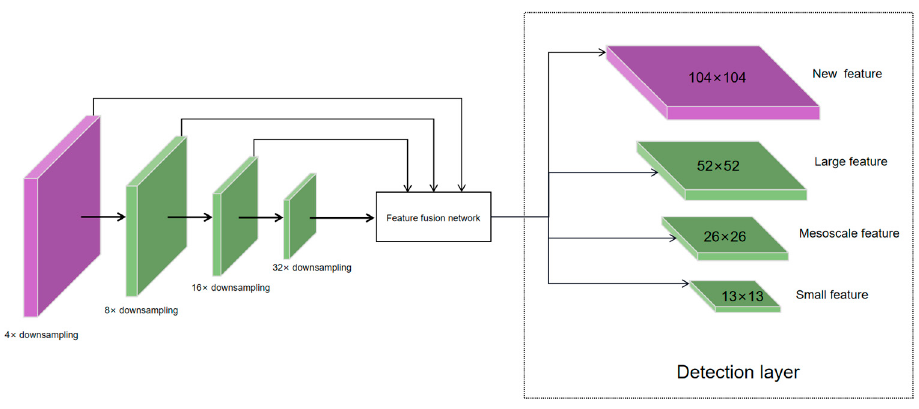
Figure 6. The improved feature extraction model.